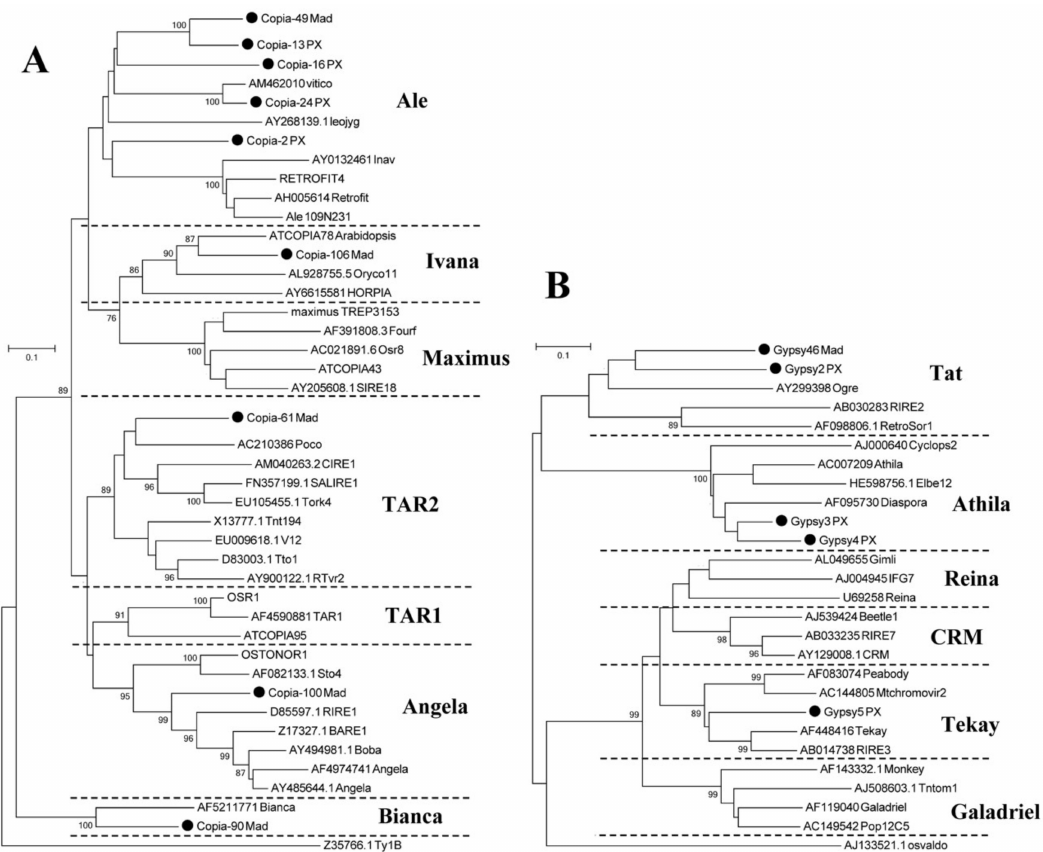
Figure 3. Phylogenetic relationships of reverse transcriptase sequences based on translated nucleotide sequences from 14 identified retrotransposons labeled with black dots. ( A ) Phylogenetic tree of copia -type reverse transcriptase sequences, including 17 identified reverse transcriptases. ( B ) Phylogenetic tree of gypsy -type reverse transcriptase sequences, including 22 identified reverse